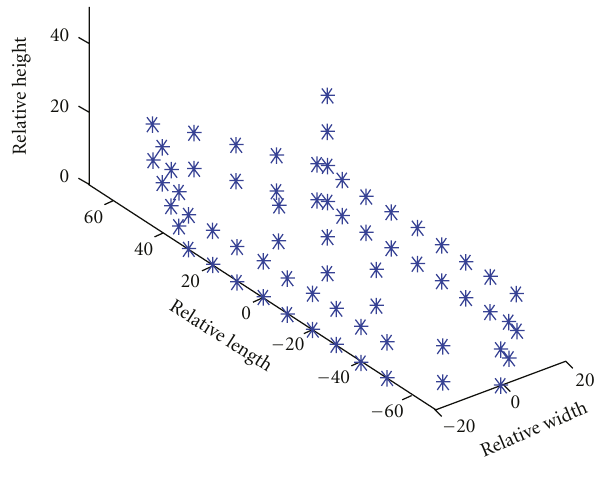
Figure 5: Simulated ship model.